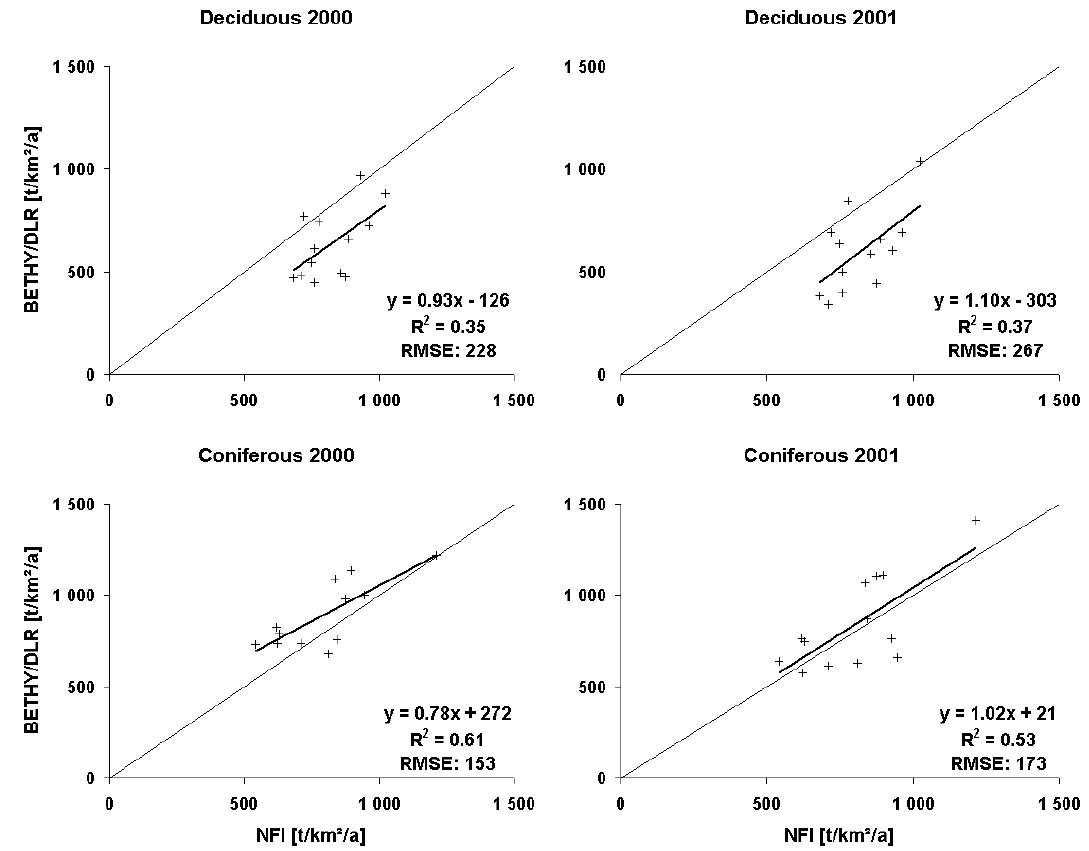
Fig. 6. Normalized estimated above-ground biomass increment from modelled NPP versus empirical data from the NFI for Germany’s deciduous and coniferous trees for 2000 and 2001. Each cross represents one NUTS-1 region. Thick lines show linear regressions. Values are given in tonskm − 2